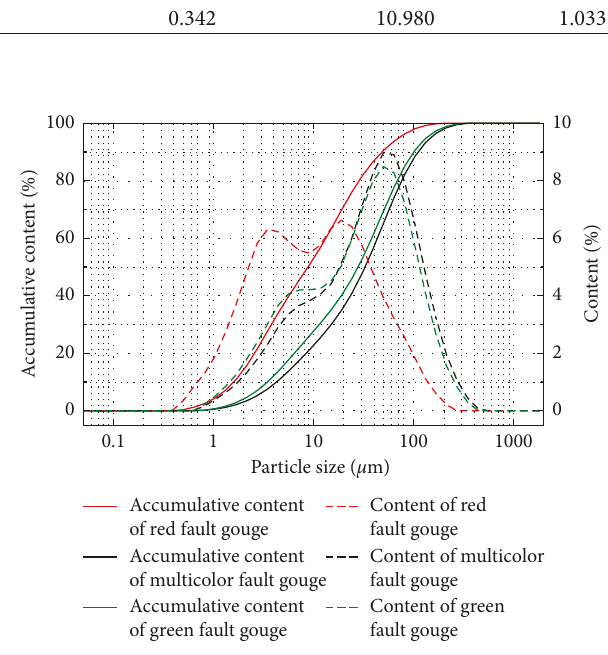
Figure 7: Gradation curves of different fault